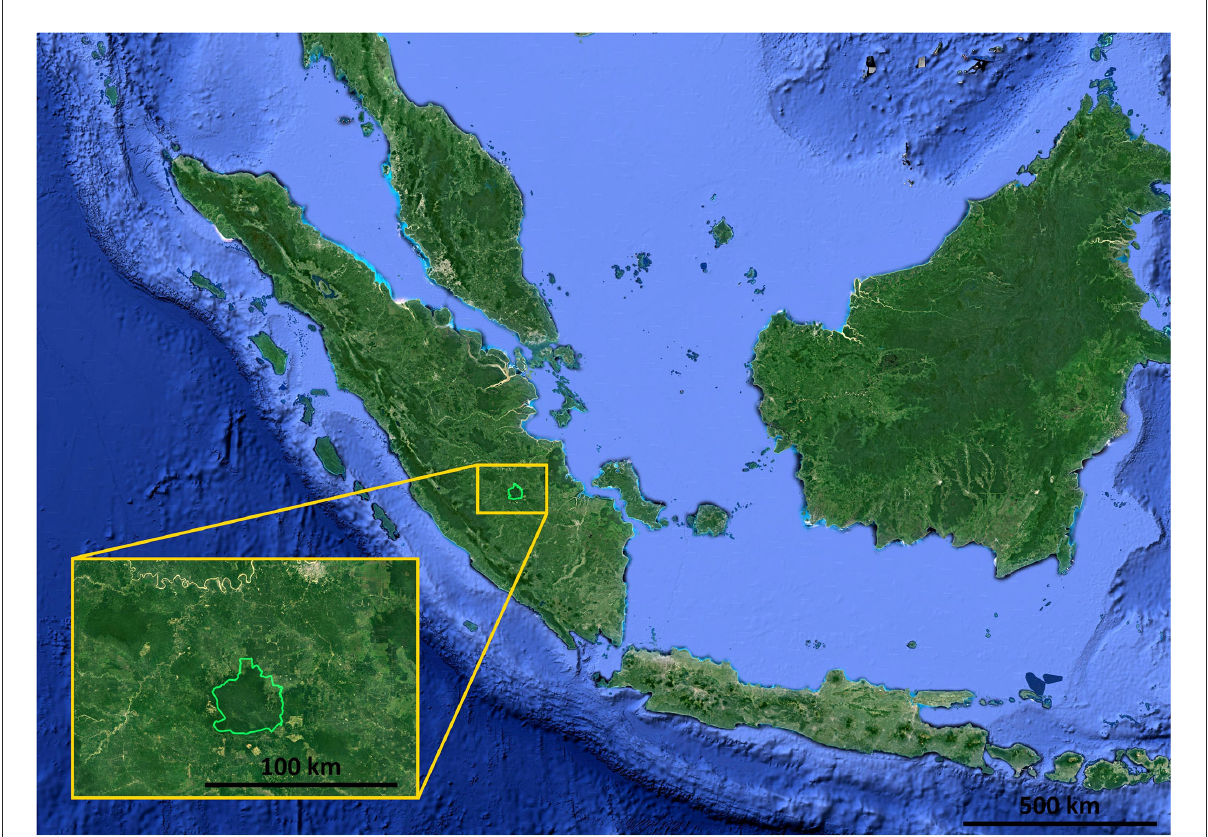
FIGURE1 Location of Hutan Harapan within Indonesia (green polygon). Imagery data courtesy of Google.